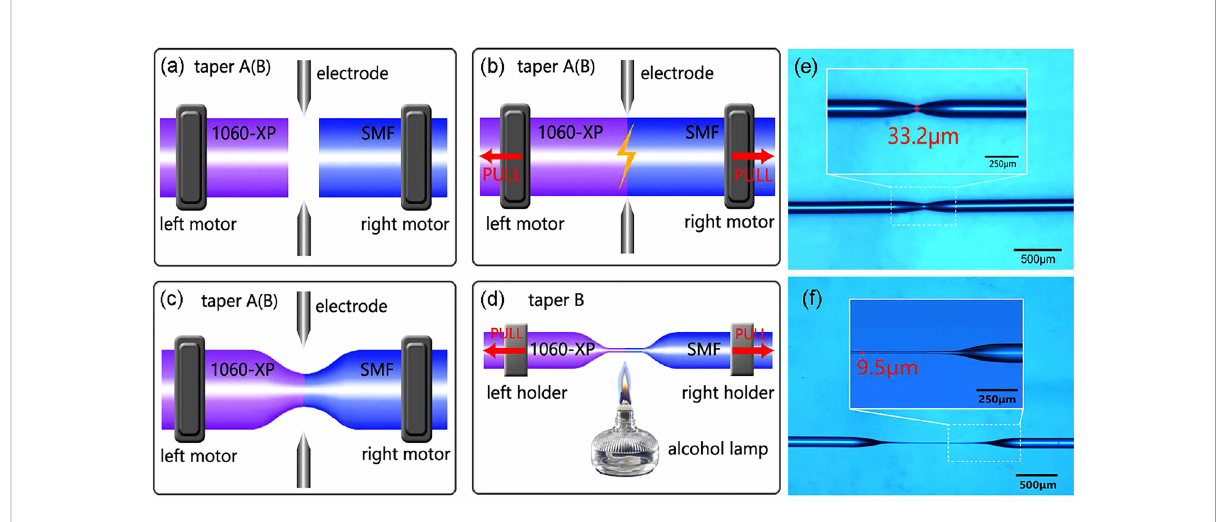
FIGURE 6 Representation of the fabrication steps of tapers to form a Mach-Zehnder interferometer: fi gures 6 (a) - 2 (c) show the fabrication steps of taper A or B. (d) Further tapering on taper B by alcohol lamp heating. Optical micrographs of the completed (e) taper A and (f) taper B (from Liu et al.,